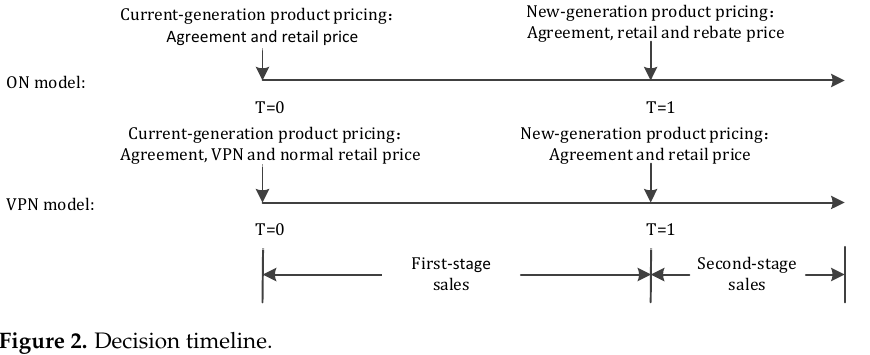
Figure 2. Decision timeline.